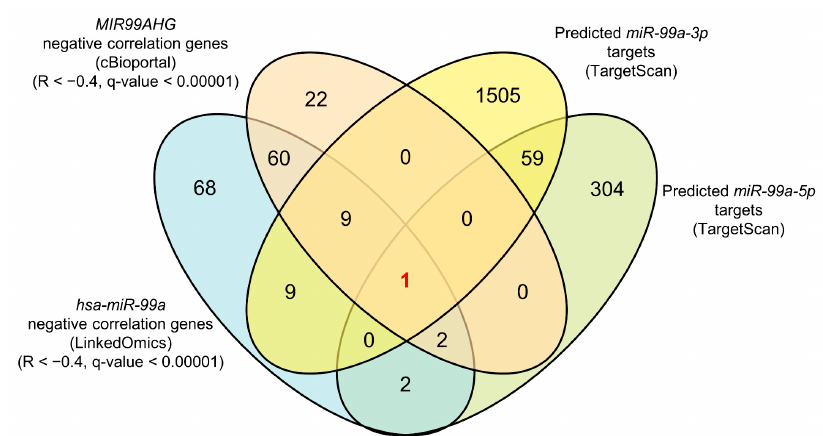
Figure 4. Identification of putative targets of miR-99a-5p or miR-99a-3p regulation in LUAD cells. Prediction of miR-99a-5p and miR-99a-3p target genes using the TargetScanHuman, cBioportal and LinkedOmics databases. Venn diagrams represent the number of putative target genes regulated by miR-99a-5p or miR-99a-3p . Table 1. Putative targets by miR-99a-5p and miR-99a-3p regulation in LUAD cells.